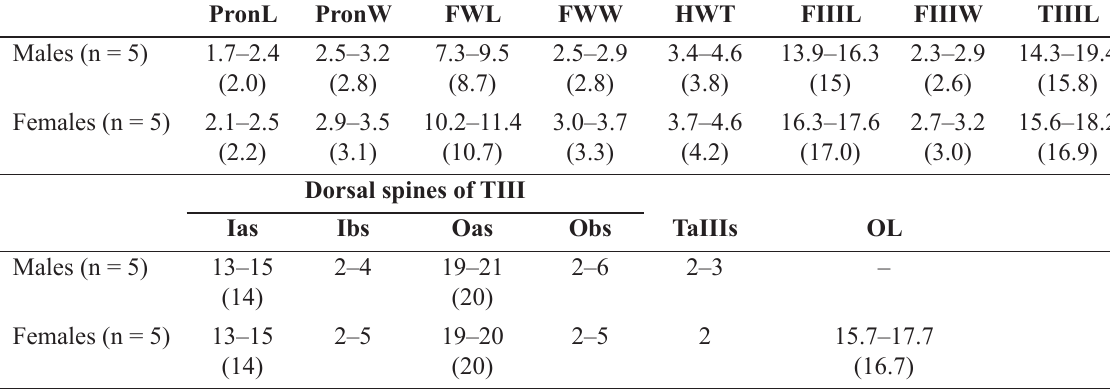
Table 7. Measurements of Nisitrus insignis Saussure, 1878 (in mm, means in